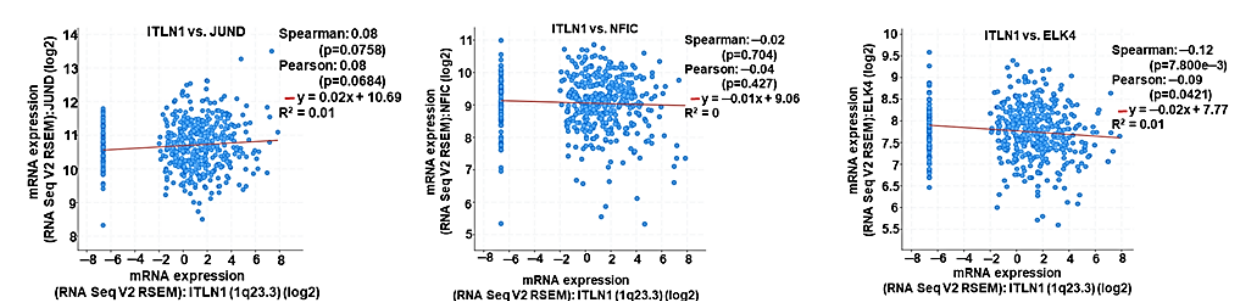
Figure 5. ITLN1 negatively correlates with oncogenic transcription factors in lung cancer. ( A ) Expression level of ITLN1 associated transcription factors in lung cancer compared to normal lungs. ( B ) Spearman correlation of ITLN1 with associated transcription factors from TCGA. LUAD: lung adenocarcinoma; LUSC: lung squamous cell carcinoma.